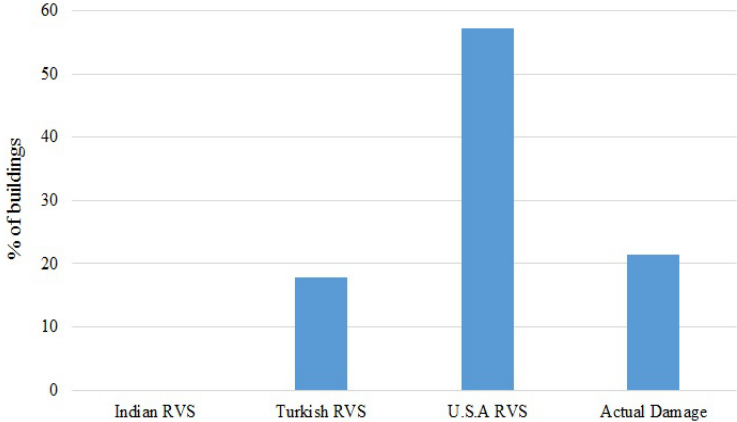
Figure 4. Percentage of buildings in damage state 1 assessed by different RVS